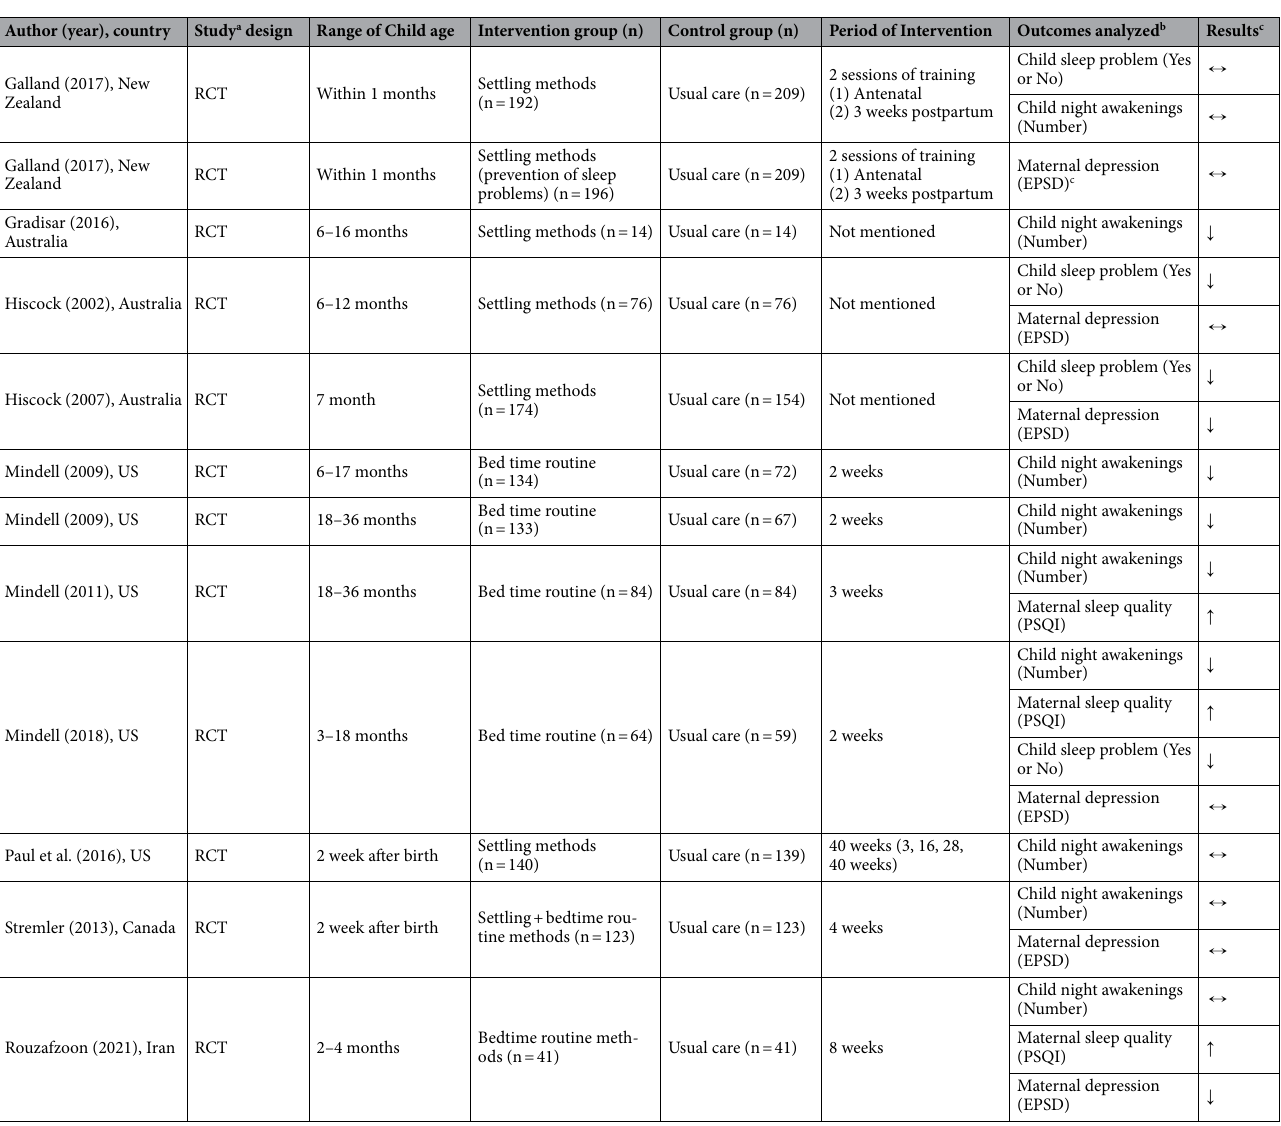
Table 1. Characteristics of included studies. a Study design: RCT, randomized controlled trial. b